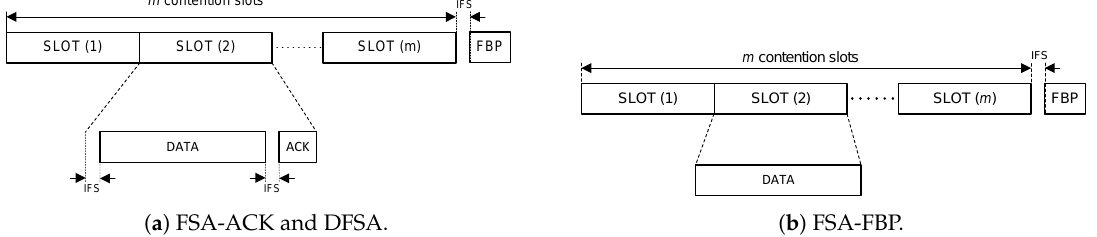
Figure 1. Frame structure of FSA (Frame Slotted ALOHA)-ACK (ACKnowledgements), FSA-FBP (FSA with FeedBack Packets) and DFSA (Dynamic